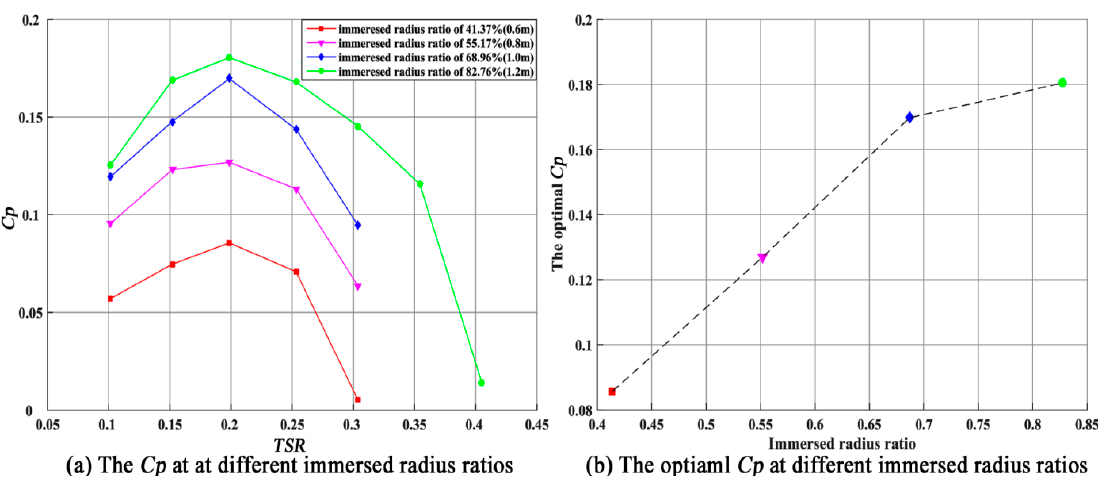
Table 2. The main characteristic parameters.